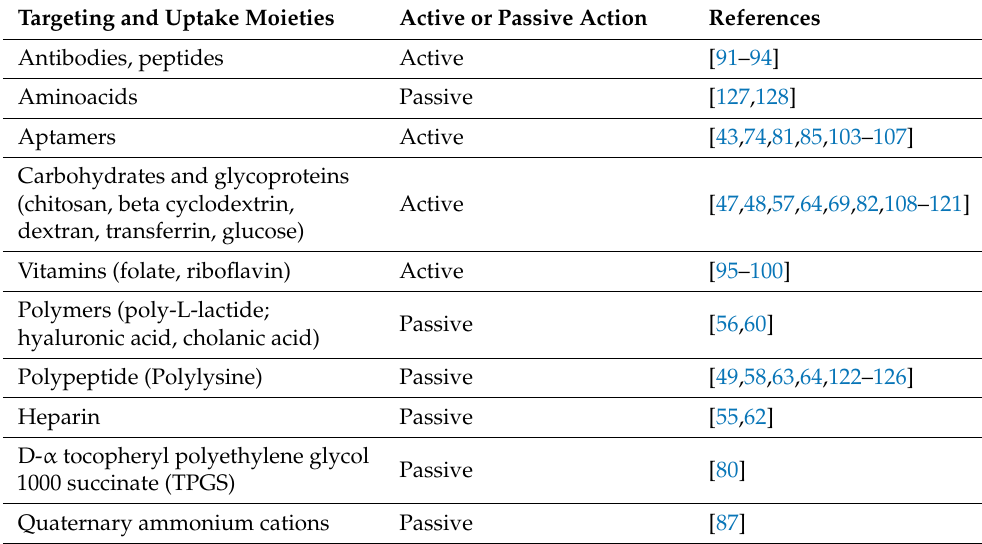
Table 1. NP surface targeting and uptake